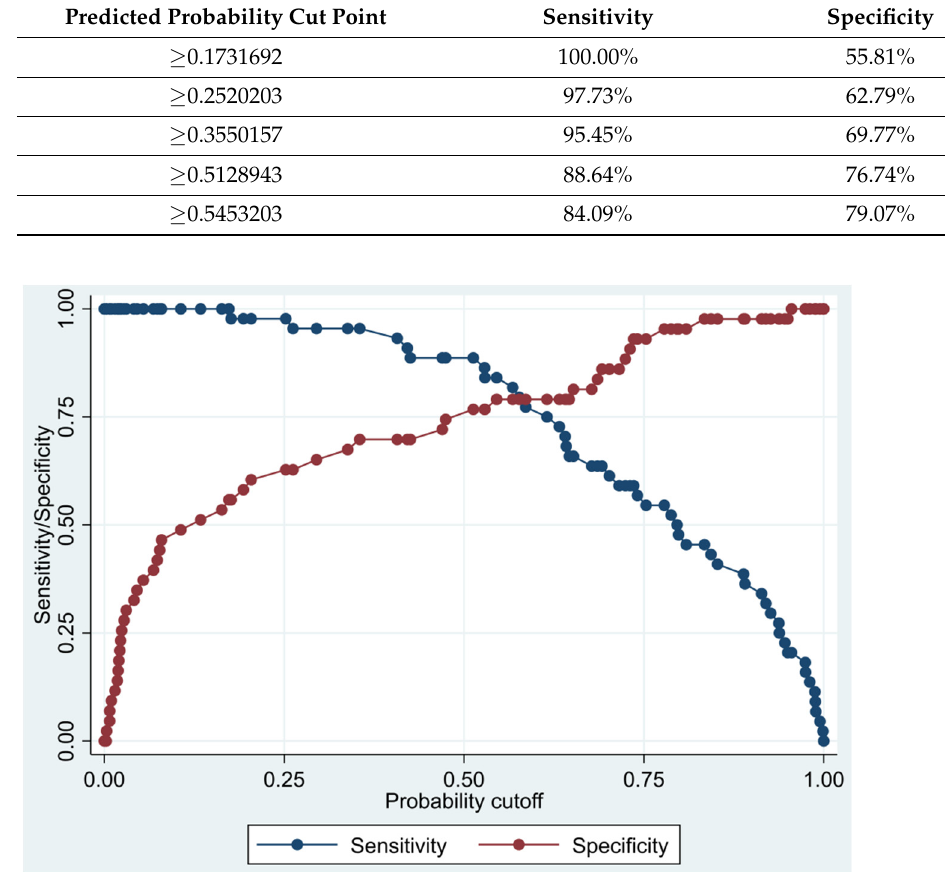
Figure 3. Sensitivity and specificity plot of the final multivariate logistic regression model based on cytokines from the oncology panel.